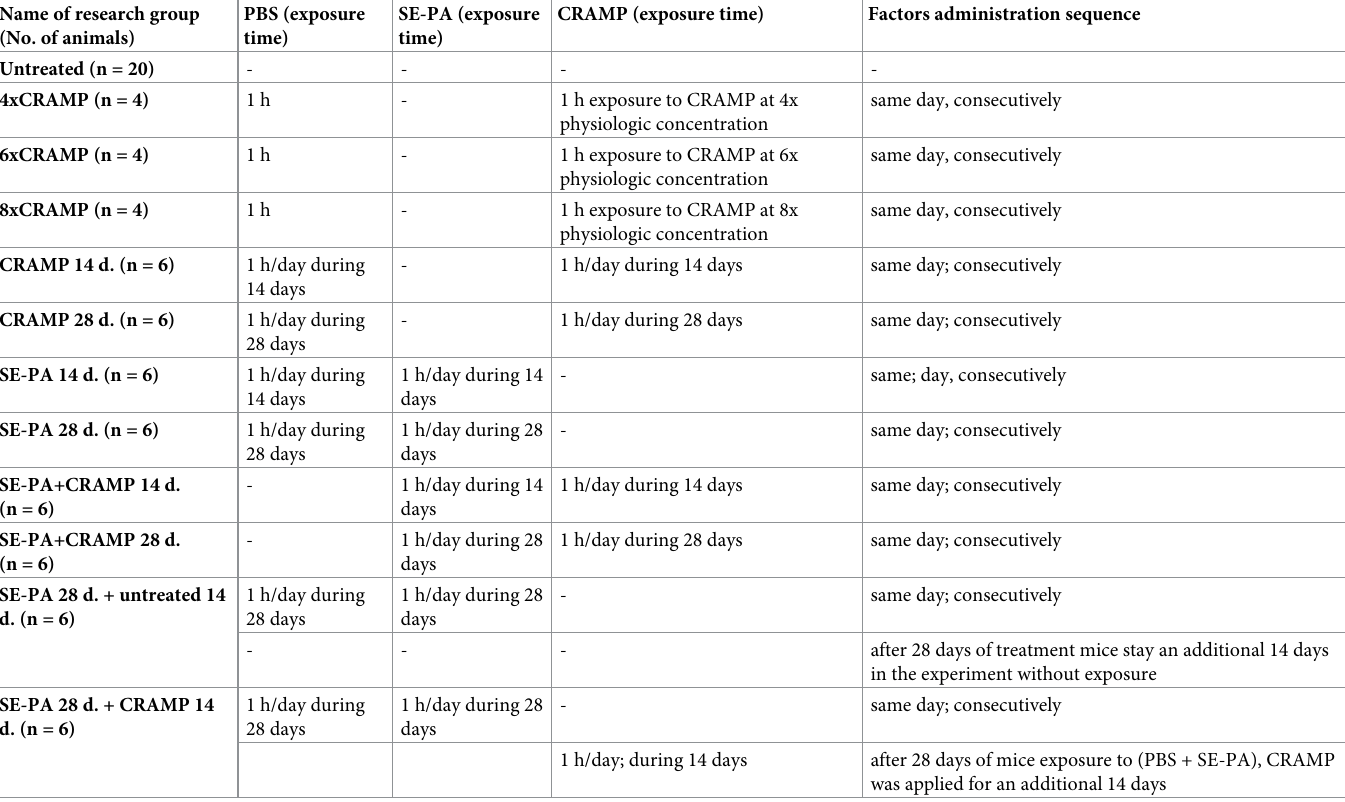
Table 1. Description of research